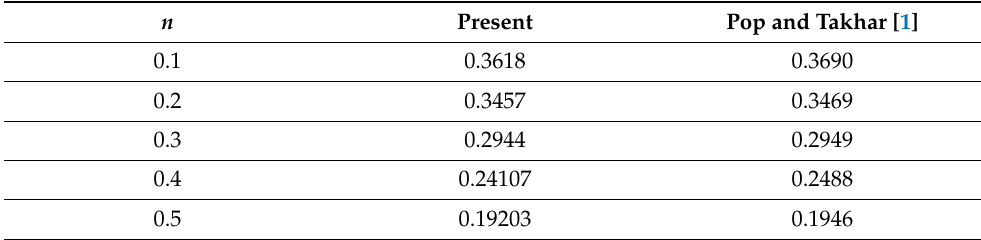
Table 1. Comparison of the obtained results for rate of heat transfer by the present author and Pop et al. [1] for different values of index parameter n and Pr =